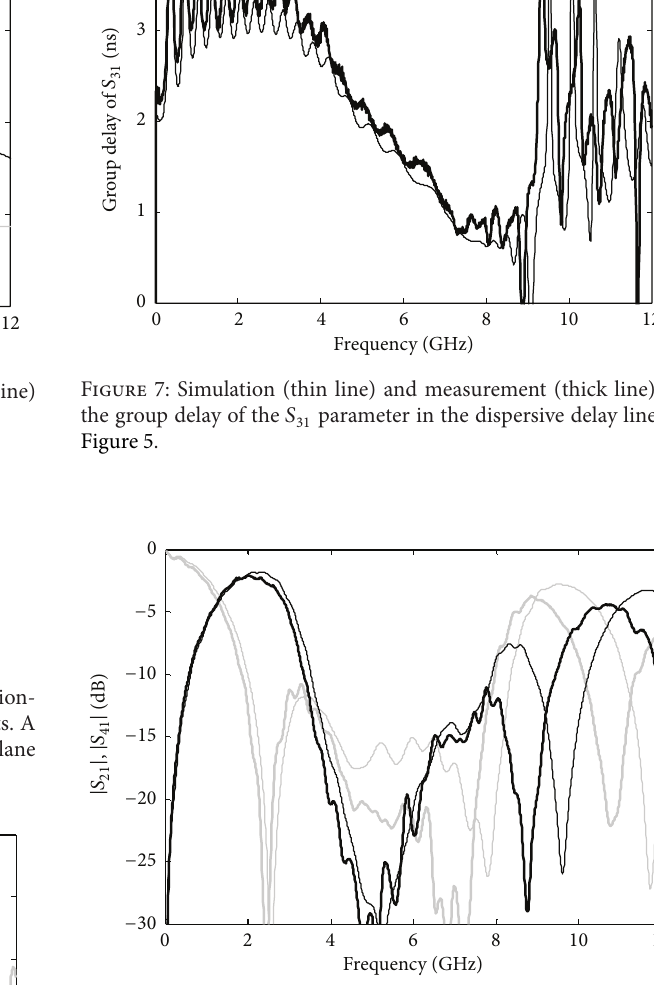
Figure 8: Simulations (thin line) and measurements (thick line) of | (grey line) and |𝑆 | (black line) in the dispersive delay line of |𝑆 21 41 Figure